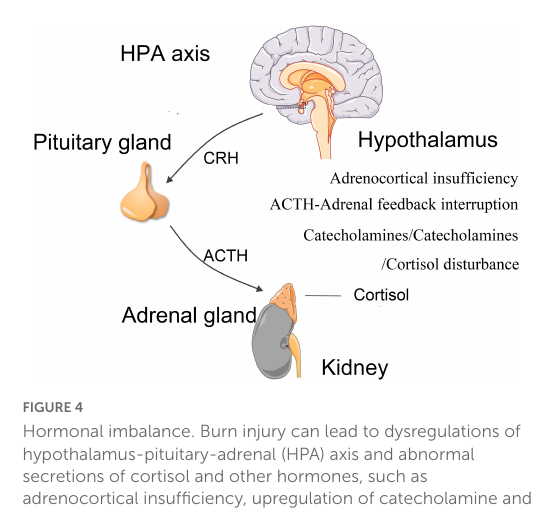
FIGURE4 Hormonal imbalance. Burn injury can lead to dysregulations of hypothalamus-pituitary-adrenal (HPA) axis and abnormal secretions of cortisol and other hormones, such as adrenocortical insufficiency, upregulation of catecholamine and corticotrophin, downregulation of cortisol. HPA, hypothalamus-pituitary-adrenal; CRH, corticotropin-releasing hormone; ACTH, adrenocorticotropic